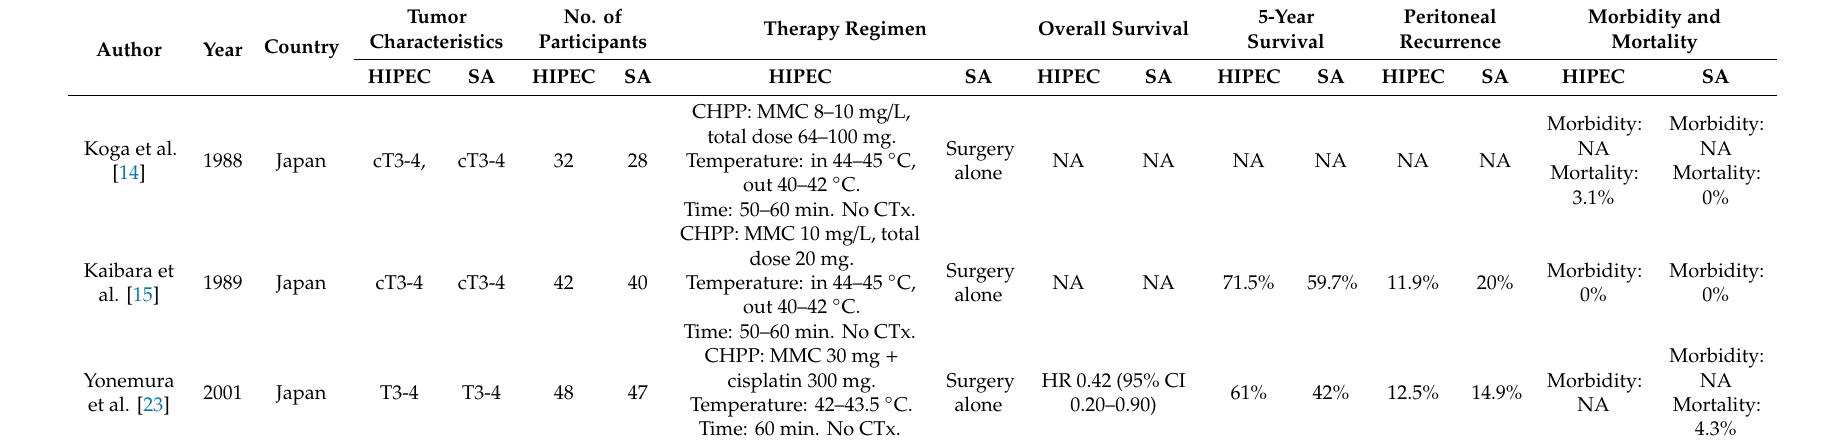
Table 3. Randomised controlled trials.